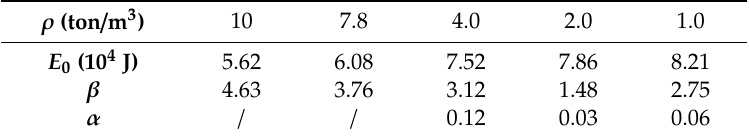
Figure 38. The comparison of internal energy and kinetic energy at density = 7.8, 4.0 ton / m 3 . Table 6. Plastic kinematic model, E = 210 GPa, υ = 0.23, f y = 210 MPa, E t = 4.0